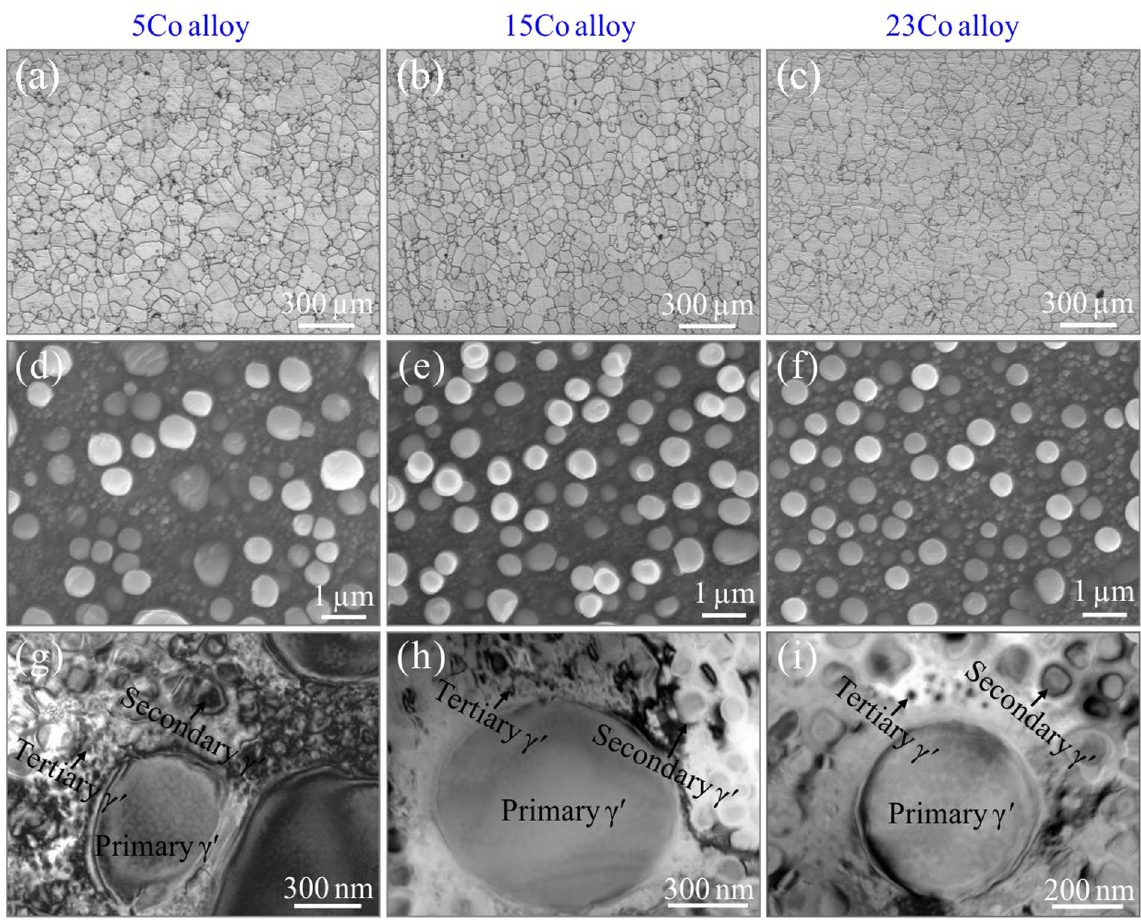
Figure 1. Microstructural observation of three superalloys under different scales. ( a – c ) Grain distribution of three alloys by optical microscope; ( d – f ) primary and secondary γ′ precipitates in three alloys by scanning electron micorscope; ( g – i ) tertiary γ′ precipitates in three alloys by transmission electron